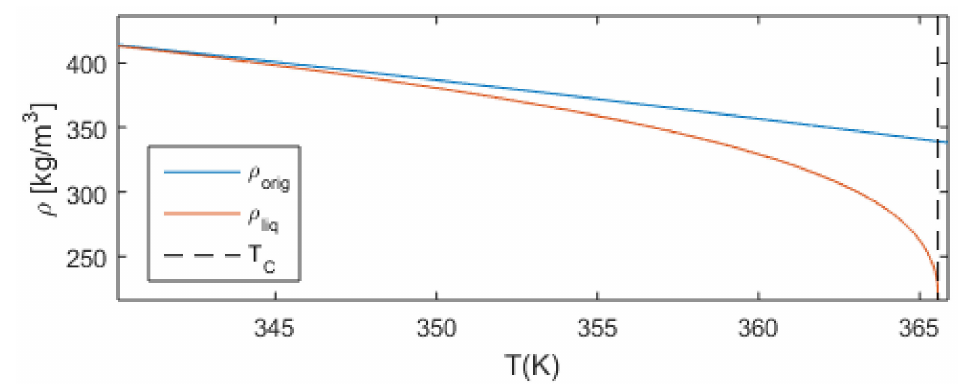
Figure 11. Densities of the saturated liquid near the critical